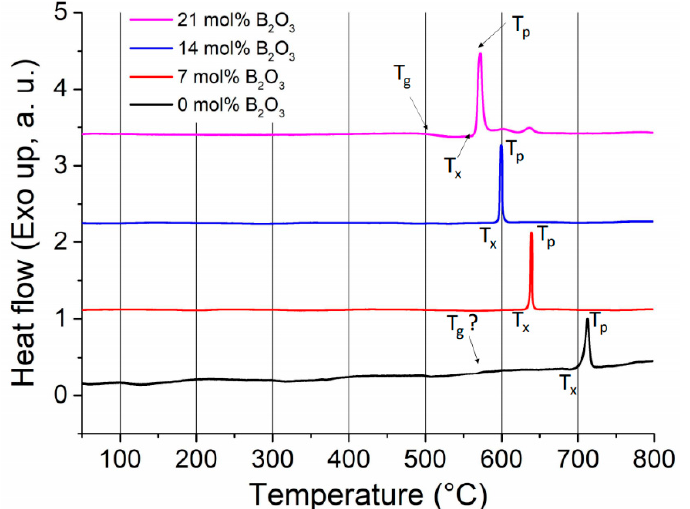
Figure 8. Differential scanning calorimetry (DSC) scans for four glasses with an increasing amount of B 2 O 3 in the batch composition; in mol%: 33Li 2 O-33Nb 2 O 5 -(34–x)SiO 2 -xB 2 O 3 , with x = 0, 7, 14, and 21. Heating rate was 10 °C/min. Black curve corresponds to LNS, while the pink curve to LNSB. T g = glass transition temperature; T p = crystallization peak temperature; T x = onset of crystallization temperature.